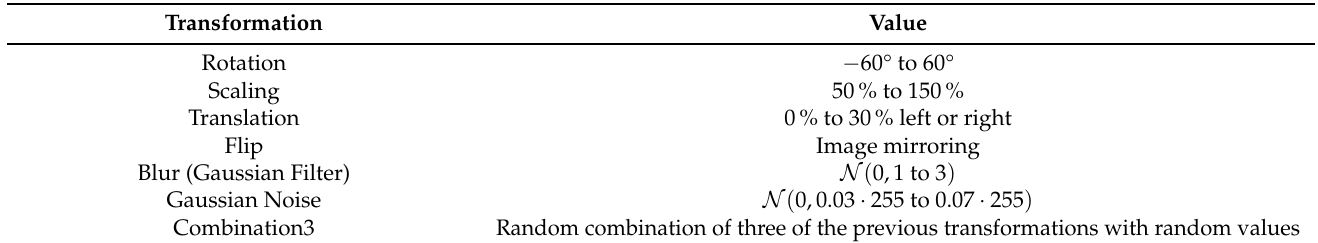
Table 2. Transformations applied to the images of the split dataset for data augmentation and the characteristics of those